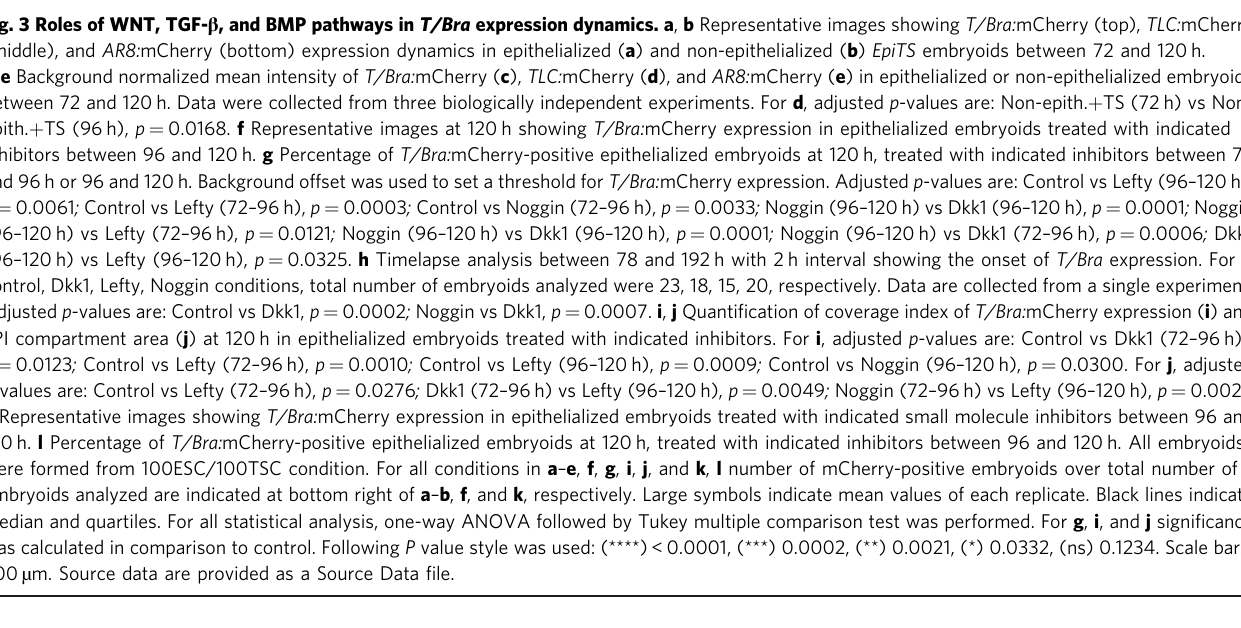
Fig. 3 Roles of WNT, TGF- β , and BMP pathways in T/Bra expression dynamics. a , b Representative images showing T/Bra: mCherry (top), TLC: mCherry (middle), and AR8: mCherry (bottom) expression dynamics in epithelialized ( a ) and non-epithelialized ( b ) EpiTS embryoids between 72 and 120 h. c – e Background normalized mean intensity of T/Bra: mCherry ( c ), TLC: mCherry ( d ), and AR8: mCherry ( e ) in epithelialized or non-epithelialized embryoids between 72 and 120 h. Data were collected from three biologically independent experiments. For d , adjusted p -values are: Non-epith. + TS (72 h) vs Non- epith. + TS (96 h), p = 0.0168. f Representative images at 120 h showing T/Bra: mCherry expression in epithelialized embryoids treated with indicated inhibitors between 96 and 120 h. g Percentage of T/Bra: mCherry-positive epithelialized embryoids at 120 h, treated with indicated inhibitors between 72 and 96 h or 96 and 120 h. Background offset was used to set a threshold for T/Bra: mCherry expression. Adjusted p -values are: Control vs Lefty (96 – 120 h), p = 0.0061 ; Control vs Lefty (72 – 96 h), p = 0.0003 ; Control vs Noggin (72 – 96 h), p = 0.0033 ; Noggin (96 – 120 h) vs Dkk1 (96 – 120 h), p = 0.0001 ; Noggin